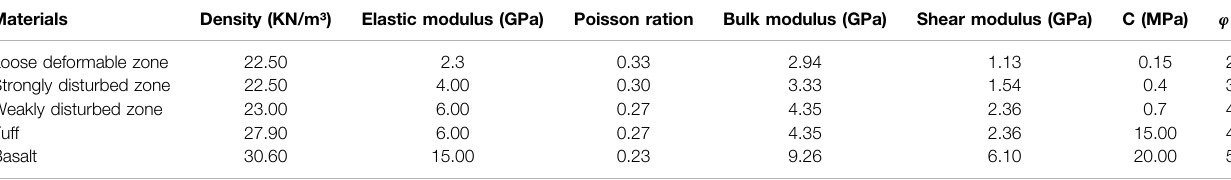
TABLE 2 | Mechanical parameters of materials.